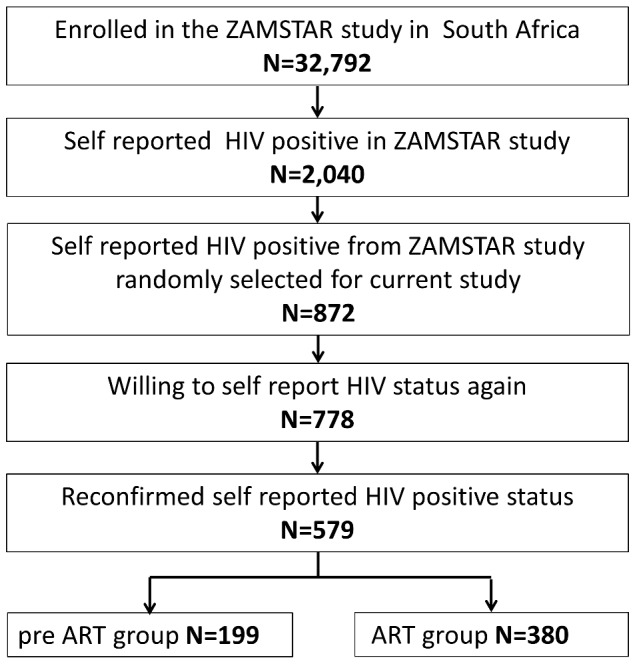
Participant Flow Chart.